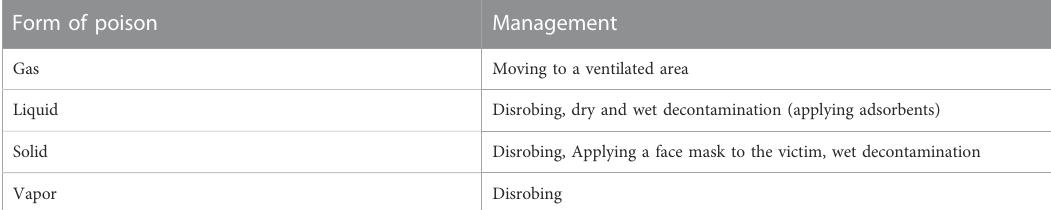
TABLE 2 Triage for nerve agent casualties (Tareg,